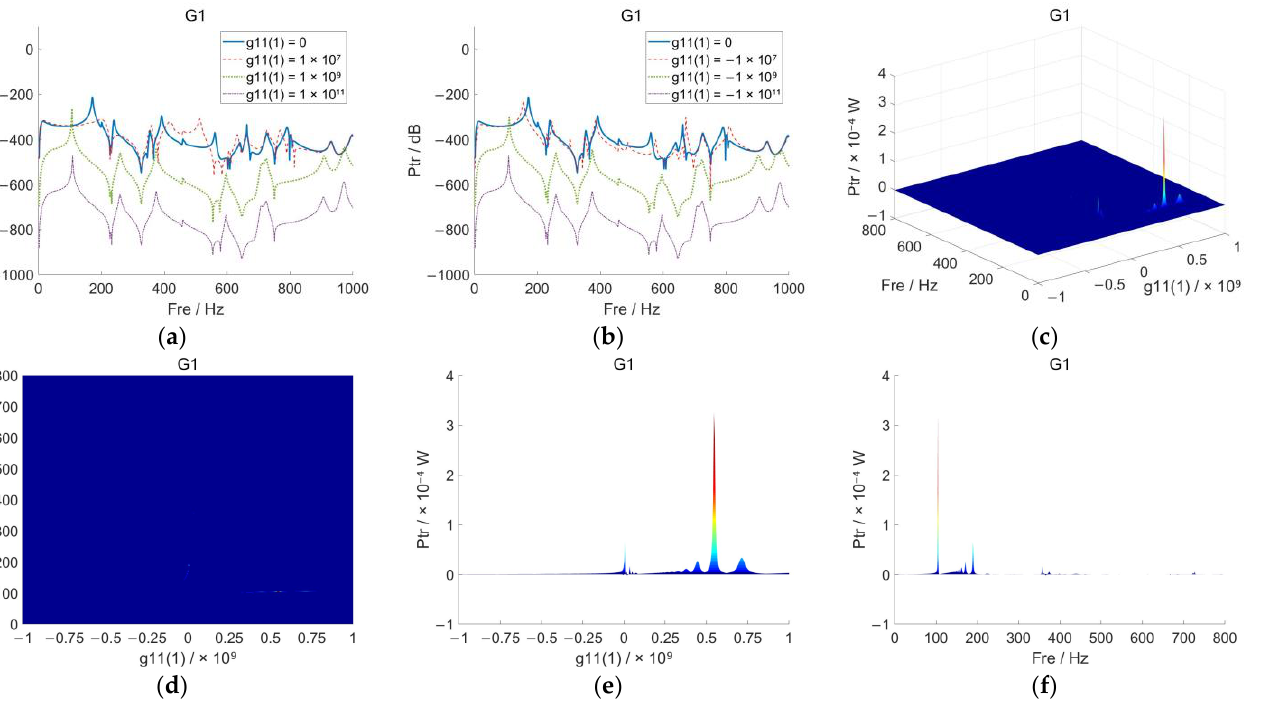
( 1 ) P under the absolute displacement feedback g — Fre — Figure 2. The 2D view and 3D view of ( ) 1 Figure 2. The 2D view and 3D view of g — Fre — P tr under the absolute displacement feedback 11 tr 11 ( 1 ) P curves under 10 10 g ,  − , the step size is set to 1 × 10 7 ): ( a ) comparison of ∈ (cid:0) − 10 11 , 10 11 (cid:1) , the step size is set to 1 × 10 7 ): ( a ) comparison of P tr curves control method ( ( ) ( ) 1 11 11 control method ( g tr 11 11 ( 1 ) > 0; ( b ) comparison of P tr curves under g ( 1 ) < 0; ( c ) the 3D view of P tr curve under ( ) 1 under g P curves under ( ) 1 P curve under continuous 0 g  ; ( b ) comparison of 0 g  ; ( c ) the 3D view of 11 11 11 11 tr tr ( 1 ) continuous variation of g ; ( d ) X-Y plane view; ( e ) X-Z plane view; ( f ) Y-Z plane g ; ( d ) X-Y plane view; ( e ) X-Z plane view; ( f ) Y-Z plane view. 11 variation of ( ) 1 11